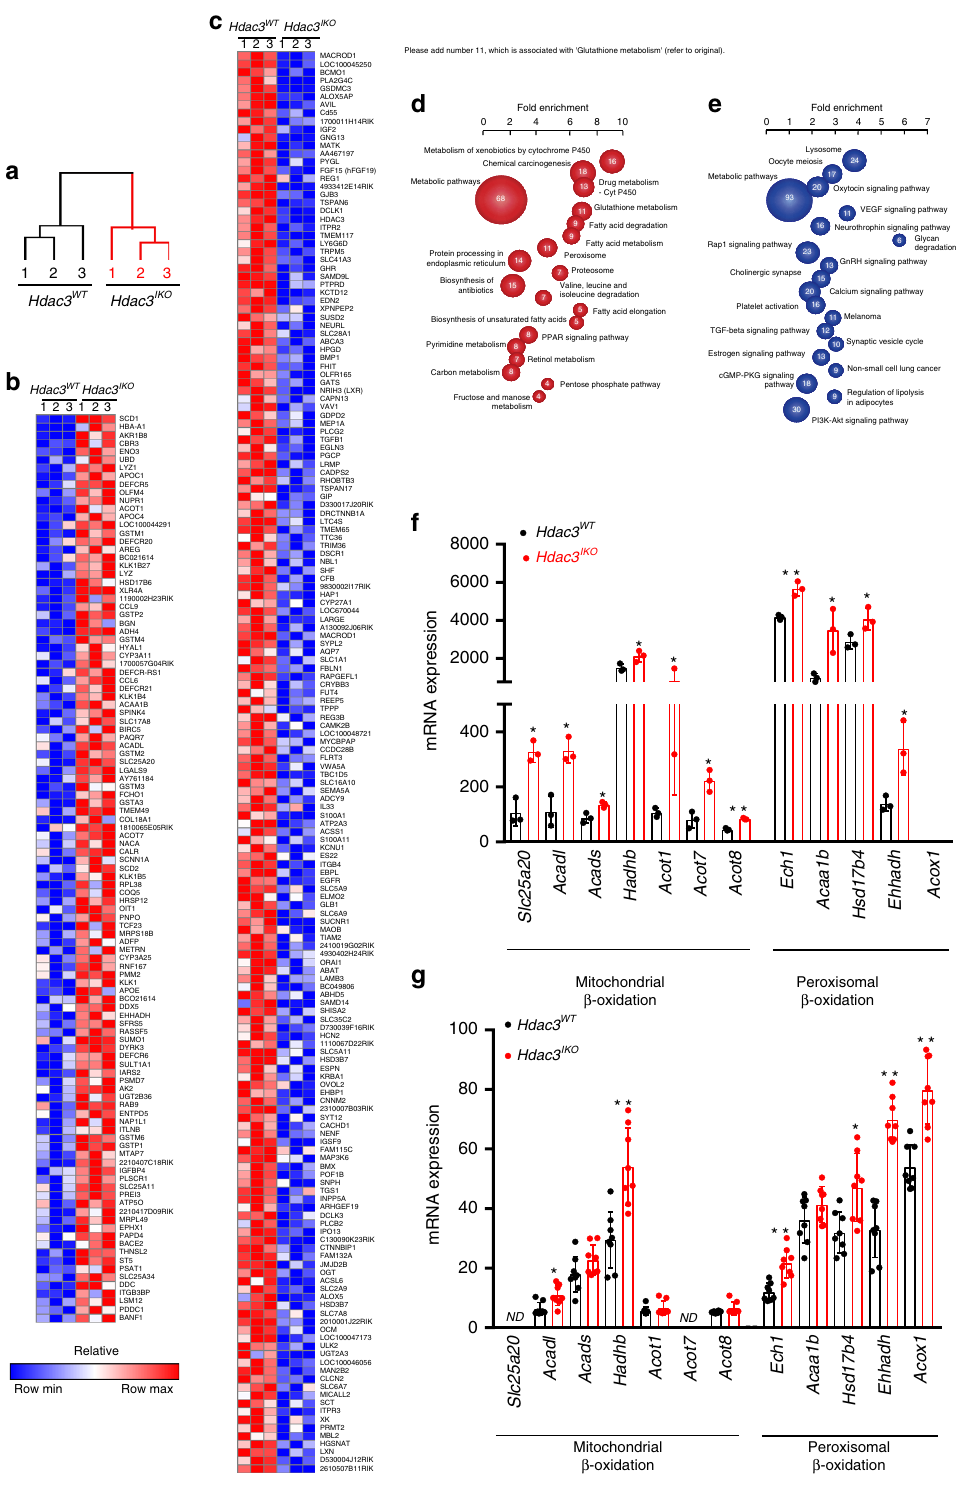
Fig. 3 Deletion of intestinal HDAC3 induces fatty acid gene expression in enterocytes. Transcriptomic pro fi ling of IECs isolated from 4 – 6-week-old Hdac3 WT and Hdac3 IKO mice fed a standard chow diet. a Unsupervised clustering of samples based on expression of all genes in IECs isolated from Hdac3 WT and Hdac3 IKO mice determined by illumina microarray analysis. b Genes upregulated and ( c ) genes downregulated in IECs isolated from Hdac3 WT and Hdac3 IKO mice. d , e Gene set enrichment analysis of transcripts differentially expressed between IECs isolated from Hdac3 WT and Hdac3 IKO mice. f mRNA and g corresponding protein expression of mitochondrial and peroxisomal β -oxidation genes in Hdac3 WT and Hdac3 IKO mice determined by transcriptomic ( n = 3 per group) and proteomic pro fi ling ( n = 8 per group) using LC-MS/MS, respectively. ND not detected. In all cases, groups were compared using an unpaired t test, * P < 0.05, ** P < 0.005.